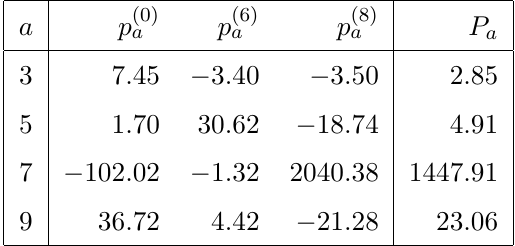
= 0 : 57 and B (3 = 2) = 0 : 6 8